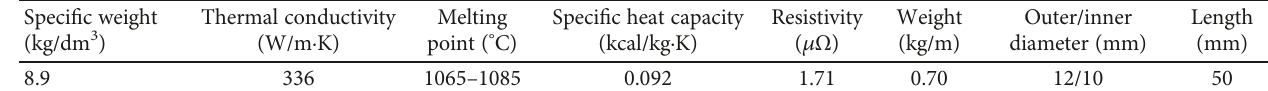
Table 1: Physical properties of copper cylindrical fi ns.